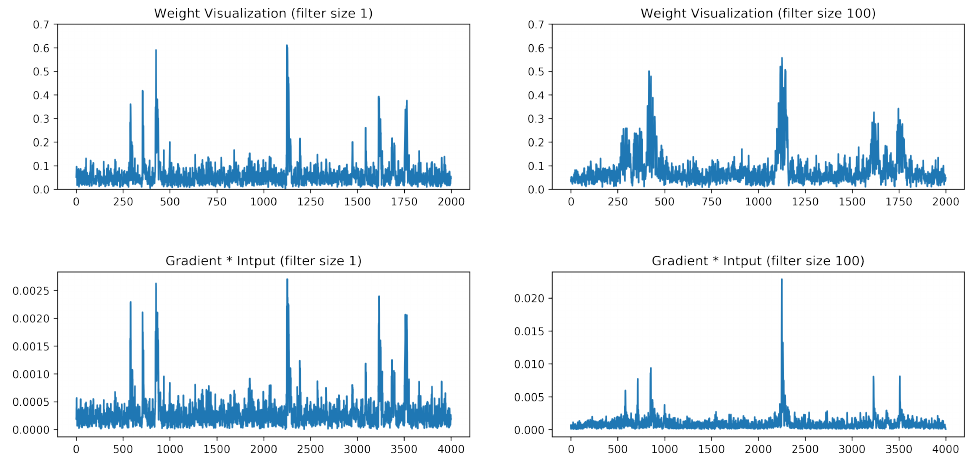
Figure 4: Weight Visualization as used by Zaid et al. (top) versus Gradient*input (bottom) for filter size 1 (left) and filter size 100 (right), using DPAv4_mod traces. Note the differences in x-axis scale between both techniques and the differences in y-axis scale between the different